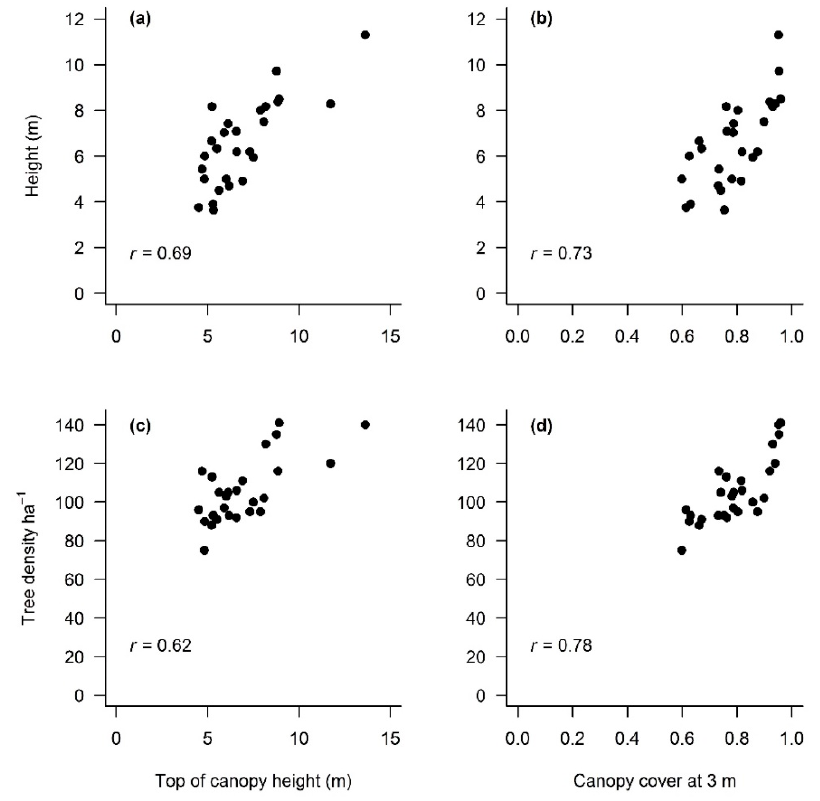
Figure 4. Spearman correlation ( r ) between field-measured average tree height per plot and LiDAR-derived ( a ) top-of-canopy-height (TCH), and ( b ) canopy cover (CC) at 3 m height, as well as between field-measured tree density (#.ha − 1 ) and ( c ) TCH and ( d ) CC.